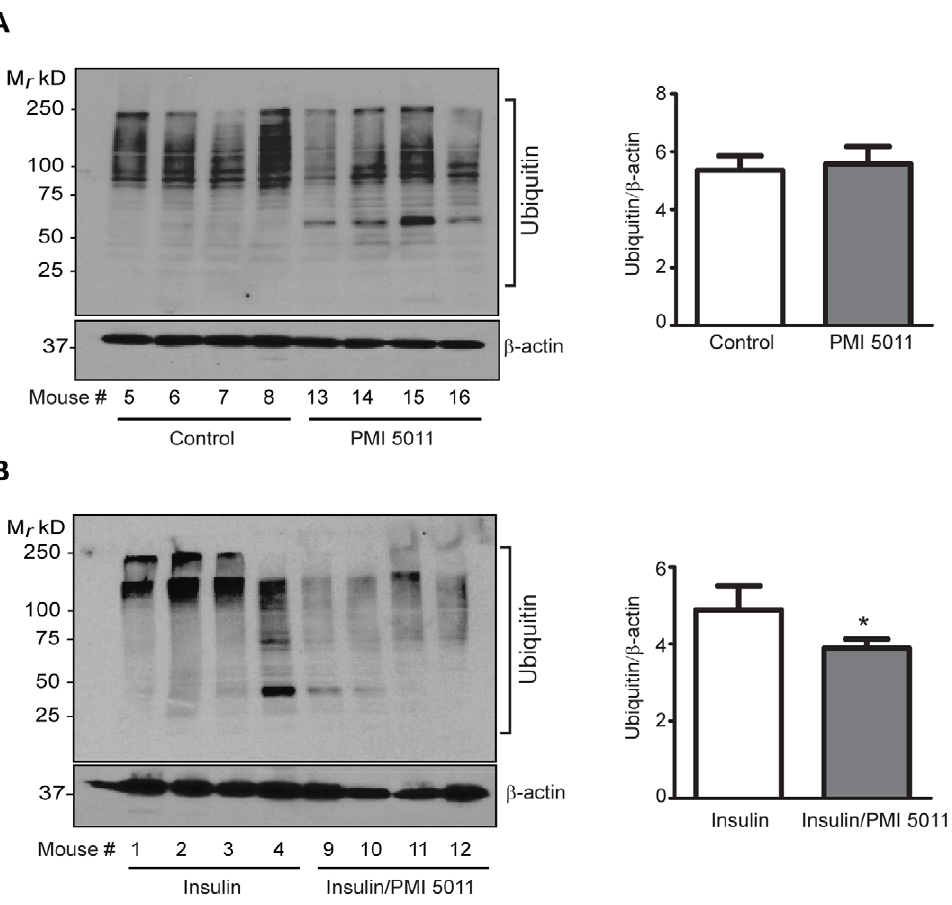
Figure 6. PMI5011 alters ubiquitin conjugation patterns in skeletal muscle. Steady-state ubiquitylation were measured in (A) control (N=4) and PMI5011 supplemented (N=4) KK-A y mice or (B) control (N=4) and PMI5011 supplemented (N=4) KK-A y mice administered insulin (1.5 U/kg IP) at the end of the study with tissue harvested 90 minutes thereafter. Whole cell extracts were subjected to SDS-PAGE followed by western blot analysis using an anti-ubiquitin antibody. b -actin is included as a loading control. Statistical significance is compared to insulin-treated animals in (B). *p , 0.05.